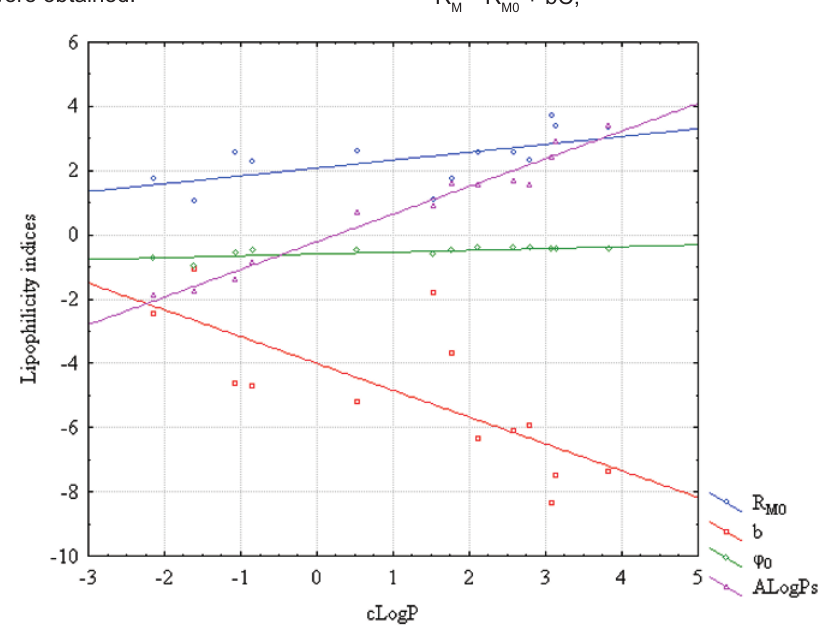
Figure 1. Scatterplot of experimental lipophilicity indices (R